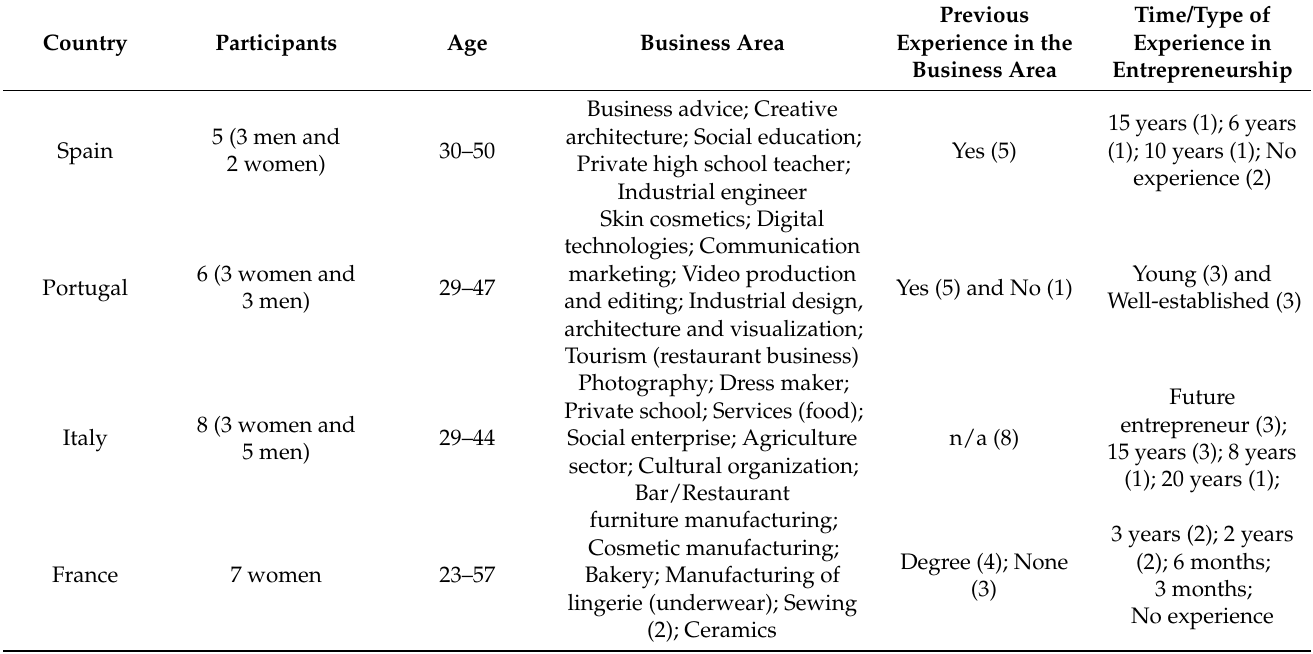
Table 2. Recruited participants per